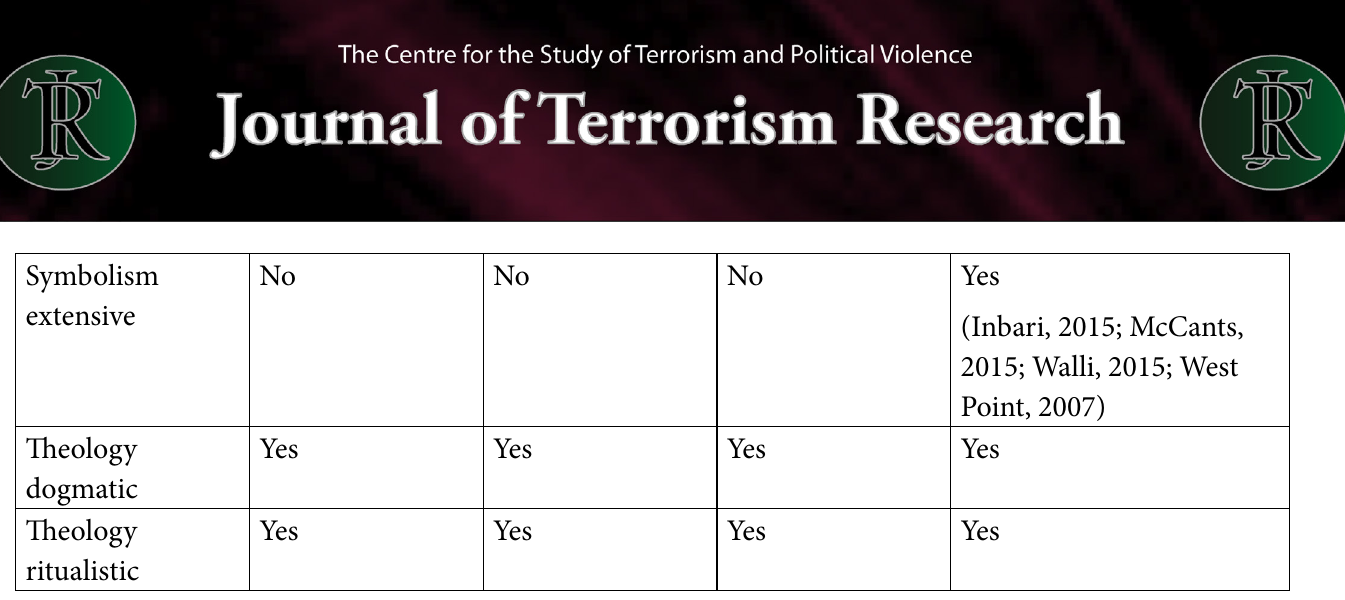
Table 3: Comparison of ISIS to Islam (religion), Sunni Islam (sect), and Salafist movement (movement) The results of the comparative analysis suggest ISIS is situated before Salafist movement on the Islamic continuum (Figure 3).